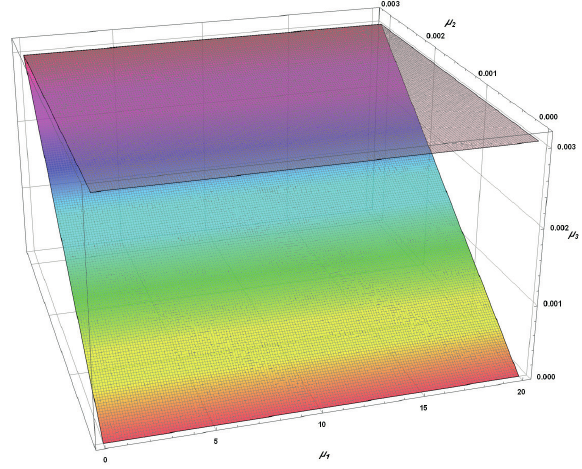
Figure 6 Partial definition area for subset А